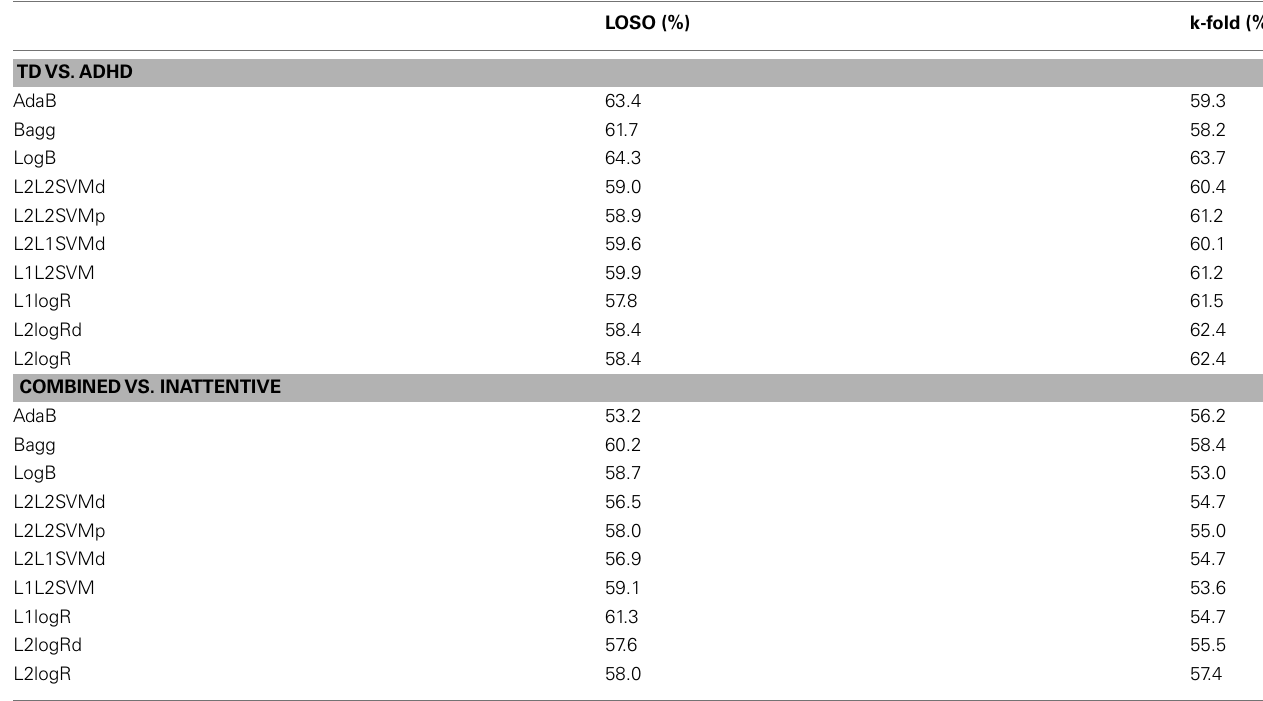
TableA3 | Classification scores [sensitivity + specificity]/2 of the leave-one-subject-out (LOSO) and k-fold cross-validation (30 subjects at each fold) when training the classifiers using all released subjects byADHD-200 competition (train and test